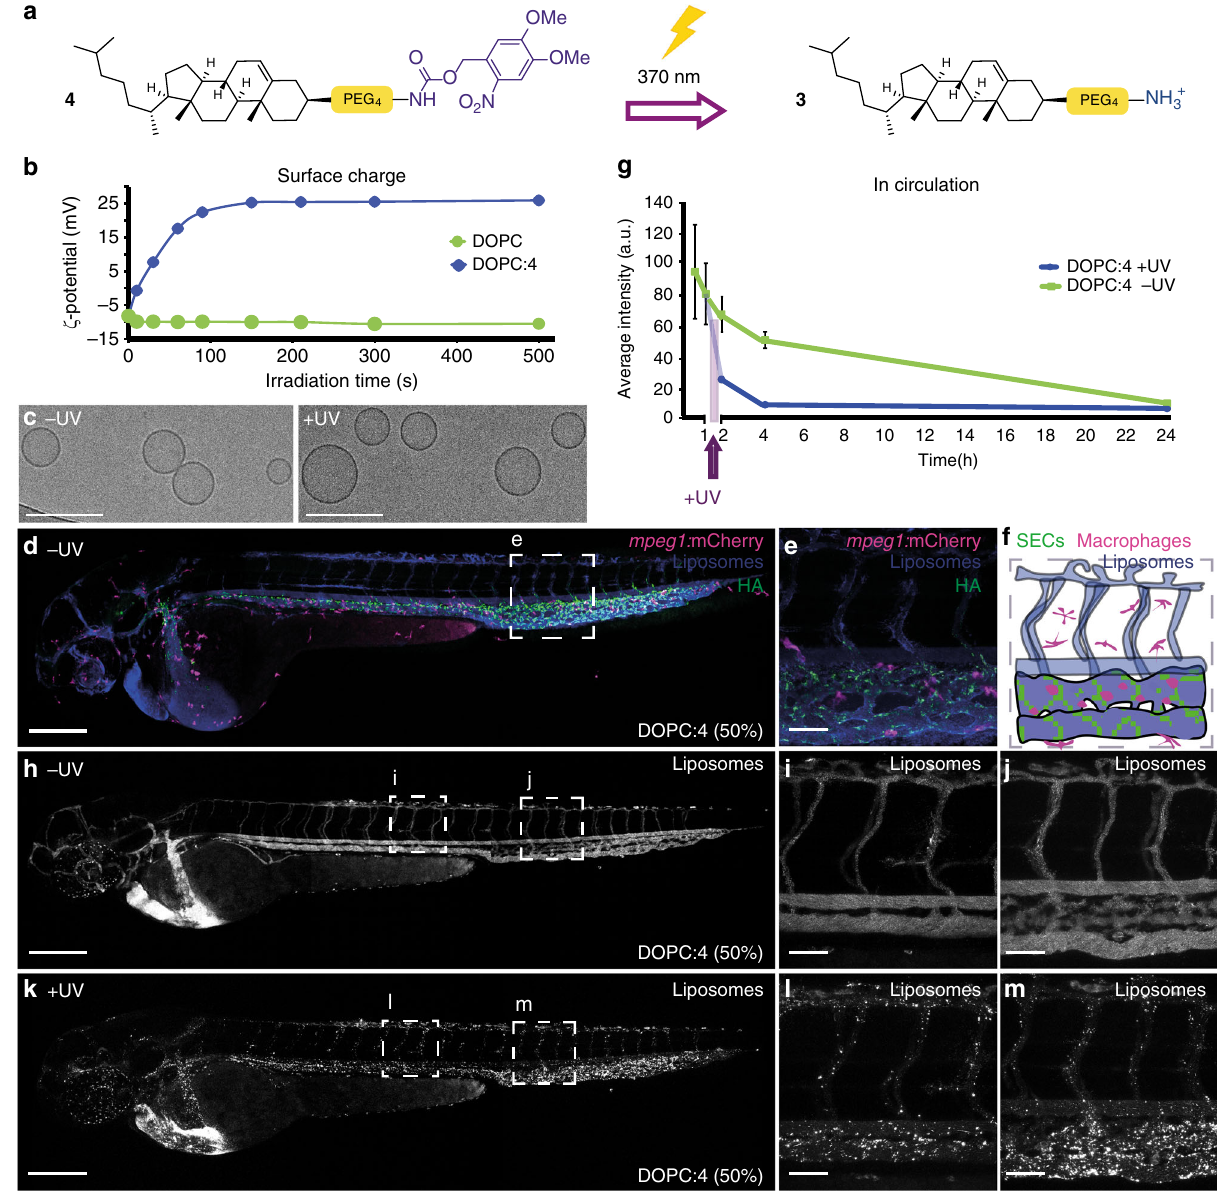
Fig. 4 Photoswitching liposome surface charge in vitro and in vivo. a Chemical structure of 4 and its photolysis to 3 . b Evolution of measured surface charge of DOPC: 4 liposomes (1:1) as a function of UV (370 ± 7 nm, 202mW cm − 2 ) irradiation time. Note: batch-to-batch variation resulted in measured zeta potentials of DOPC: 4 → 3 liposomes ranging from + 20 to + 35 mV. Data presented is representative of liposomes used in Fig. 3h – m. 100% DOPC control liposomes demonstrate surface charge of liposomes without photoactive lipids is unaffected by UV irradiation. c Cryo-TEM images of DOPC: 4 before and after in situ irradiation (15 min, 370 ± 7 nm, 202 mW cm − 2 ). Scale bar: 200 nm. See Supplementary Information Fig. 5 for low magni fi cation cryoTEM images. d , e Whole embryo and tissue level views of DOPC: 4 liposome biodistribution following co-injection with fl uoHA in mpeg1:mCherry transgenic embryos (2 dpf). FluoHA is a speci fi c in vivo marker of SECs and does not compete with liposome binding 25 . Liposomes ( d , e ) contained 1 mol% fl uorescent lipid probe, DOPE-Atto633, for visualization. f Tissue level organization of macrophages and fl uoHA-labelled SECs within the tail region of an mpeg1:mCherry embryo (2 dpf). g Quanti fi cation of DOPC: 4 liposome levels in circulation based on mean liposome fl uorescence intensity in the lumen of the DA at 0.5, 1, 2, 4 and 24 hpi (measure of centre: median; error bars: standard deviation); n = 6 (0.5 and 1 hpi) and n = 3 (2, 4 and 24 hpi) individually injected embryos per formulation per time point (see Fig. S7 for individual images). h – j Whole embryo and tissue level views of DOPC: 4 liposome biodistribution in kdrl:GFP embryos, prior to UV irradiation, 1 hpi. k – m Whole embryo and tissue level views of DOPC: 4 → 3 liposome biodistribution in kdrl: GFP embryos, directly after in situ irradiation (15 min, 370 ± 7 nm, ~90 mW cm − 2 , ~2.4 J per embryo), ~1.5 hpi. Liposomes ( h – m ) contained 1 mol% fl uorescent lipid probe, DOPE-LR, for visualization. Scale bars ( d – m ): 200 μ m (whole embryo); 50 μ m (tissue